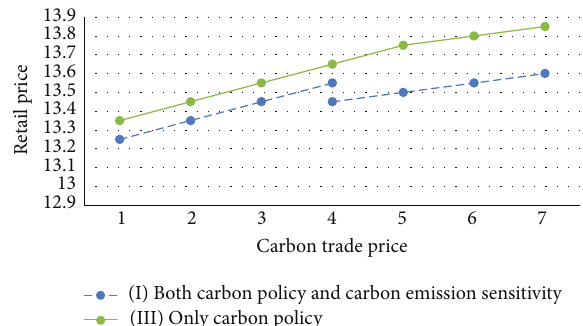
Figure 8: Effect of carbon trade price on order quantities.